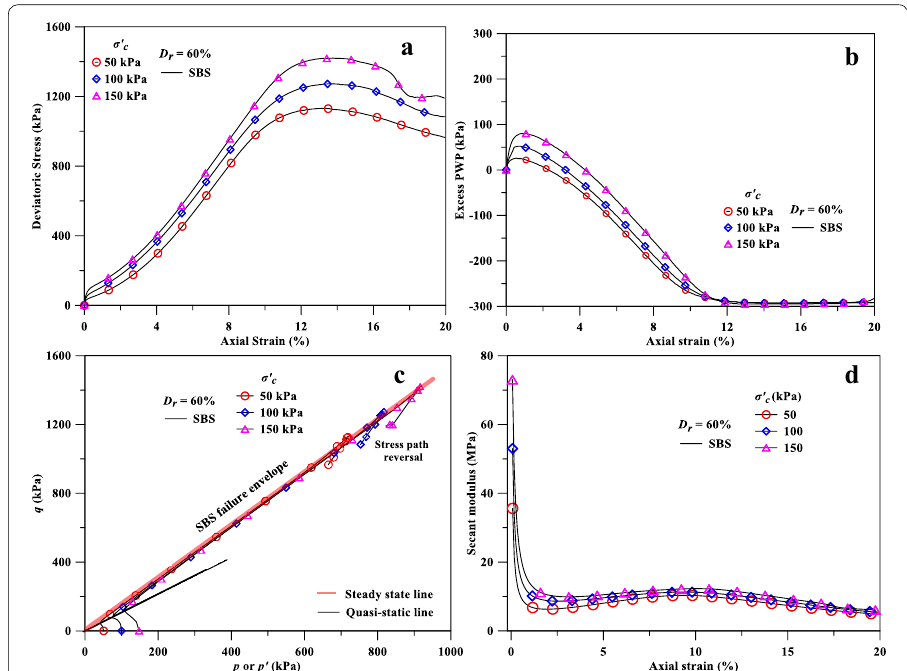
Fig. 6 Influence of σ ′ c on the response of SBS prepared at 60% relative density and subjected to monotonic loading a stress–strain response, b excess PWP, c stress path, d secant